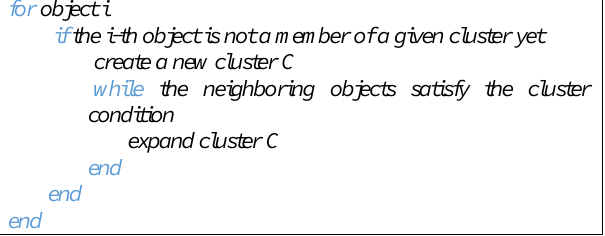
Figure 1. Overall steps of DBSCAN algorithm (Lehtomäki, Jaakkola et al.